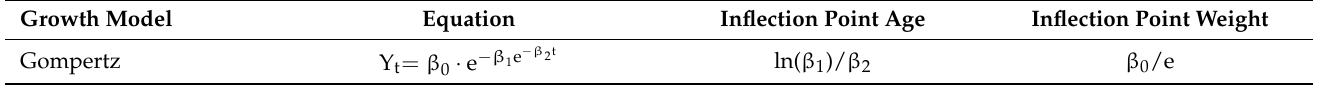
Table 2. Expression and point of inflection coordinates of Gompertz growth